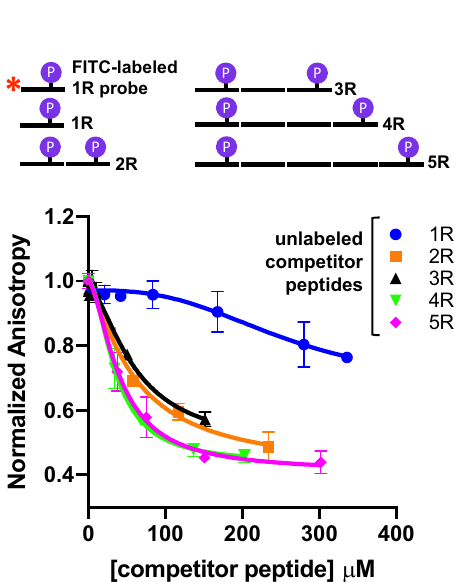
Fig. 3 Fluorescence anisotropy measurements indicate that Ess1 binding favors longer CTD substrates. A competition assay was performed using unlabeled 1R – 5R CTD peptides to compete with an FITC-labeled 1R-CTD peptide (1 μ M) for Ess1 (50 μ M) binding. A 1 repeat CTD peptide labeled